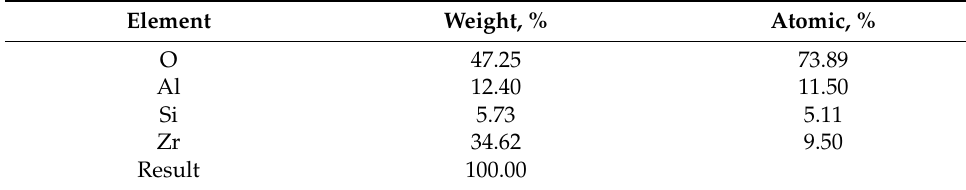
Table 4. Elemental proportions in point 4 of the sample